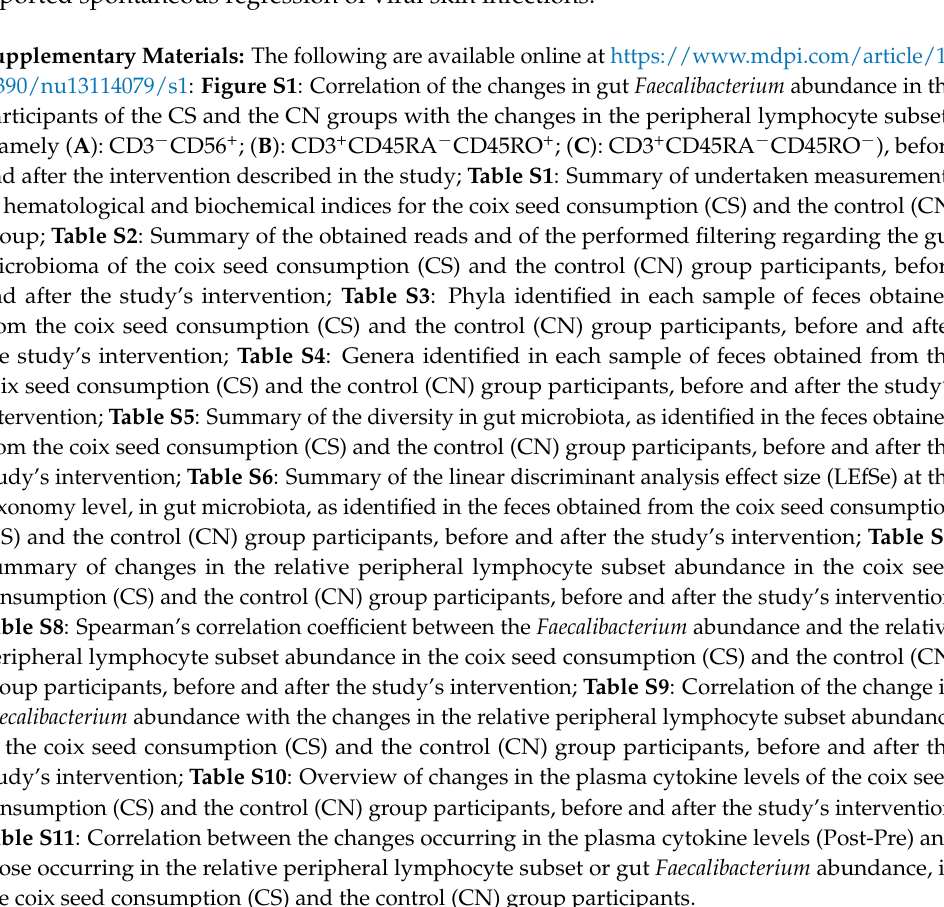
Table S11 : Correlation between the changes occurring in the plasma cytokine levels (Post-Pre) and those occurring in the relative peripheral lymphocyte subset or gut Faecalibacterium abundance, in the coix seed consumption (CS) and the control (CN) group